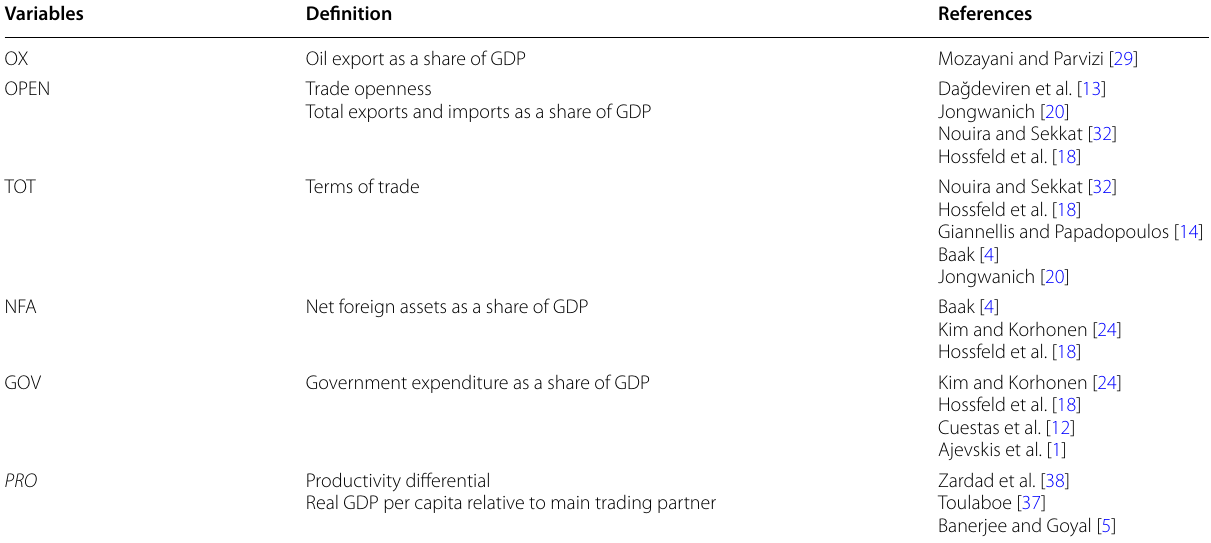
Table 1 Equilibrium exchange rate model variables and sources Variables